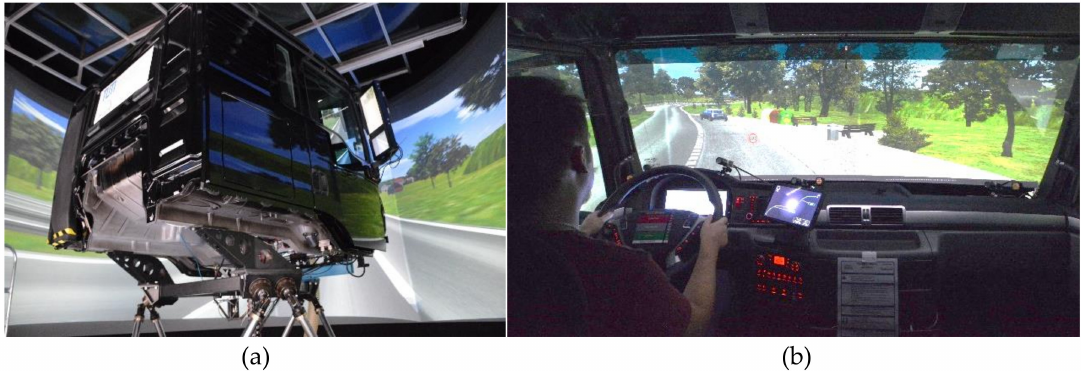
Figure 2. Depiction of the driver cabin (( a ): outside; ( b ): inside).